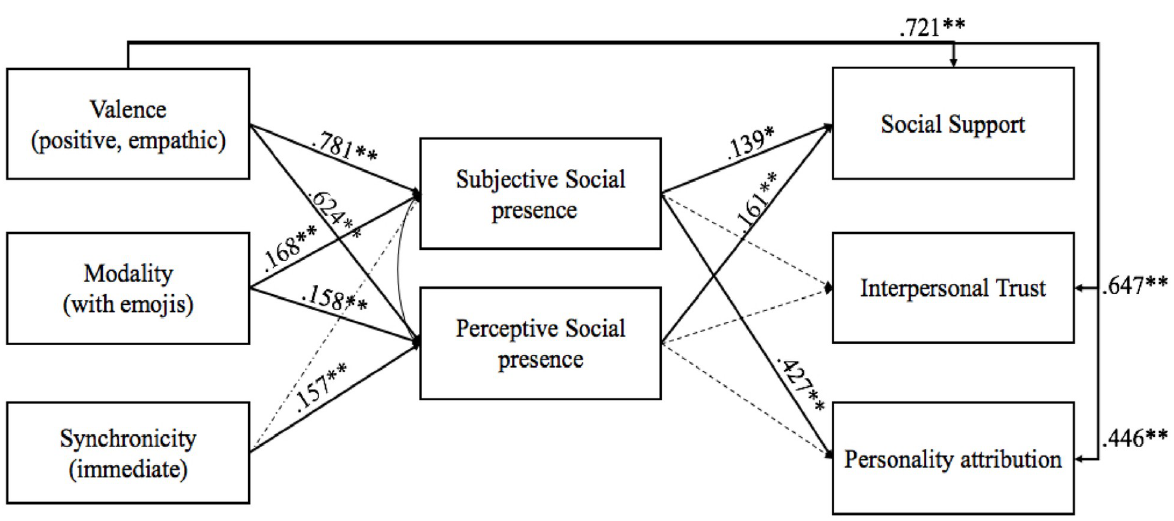
Fig 2. Final model with social support, interpersonal trust, and personality attribution as dependent variables and subjective and perceived social presence as mediators. Standardized coefficients are shown. Reference groups: valence (negative, non-empathic), modality (without emojis), synchronicity (7 minutes delay). Dashed arrows denote non-significant paths; all other paths denote significant relationships at � p < .05, �� p < .01, ��� p < .001.